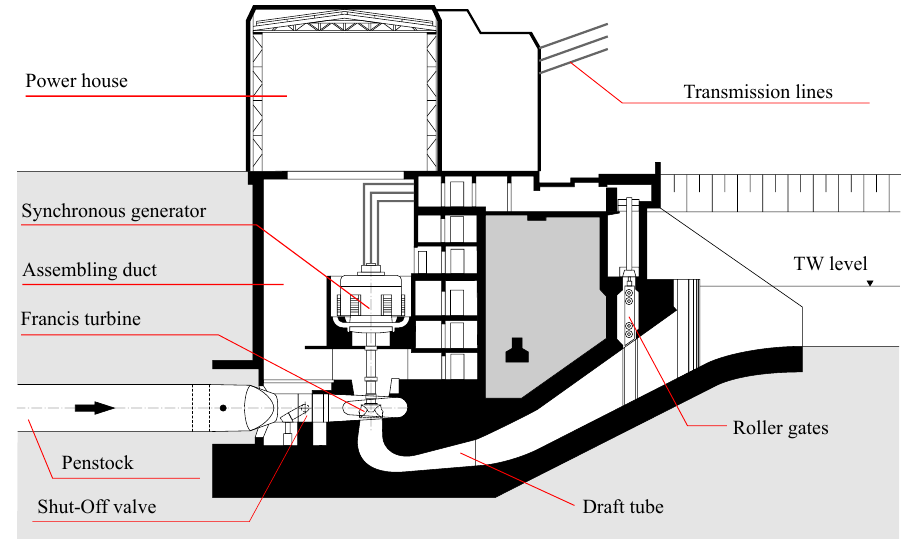
Figure 3. Sketch of the hydropower plant. Table 2. Machine main